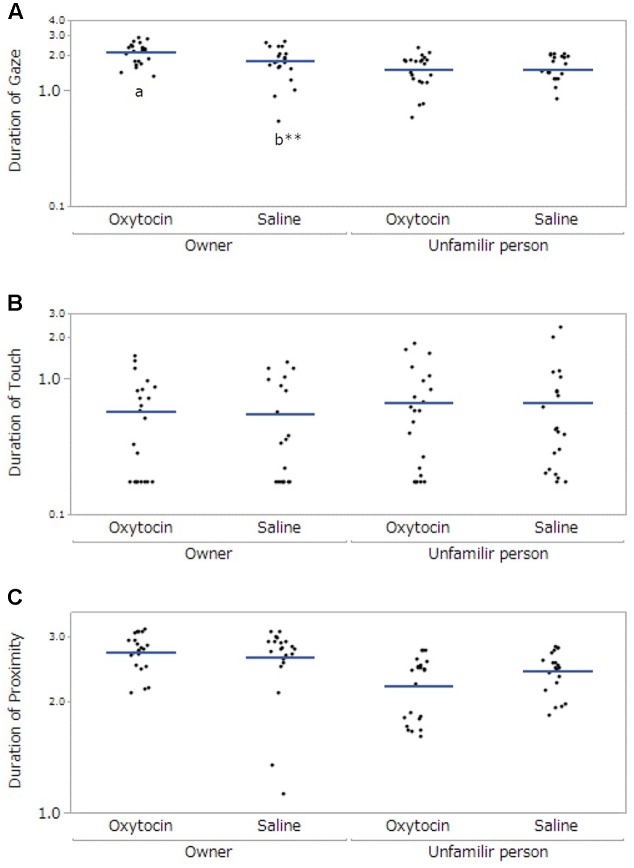
Comparisons of the dogs’ behaviors between oxytocin and saline treatment conditions. Panels show the mean duration of time of dogs’ gaze at participants (A), touching participants (B), and at proximity of less than 0.7 m from each participant (C). A significant difference between treatment conditions was observed only in gazing behavior. Results are shown with logarithmic. The blue lines indicates the mean duration of behaviors. ∗∗p < 0.001.